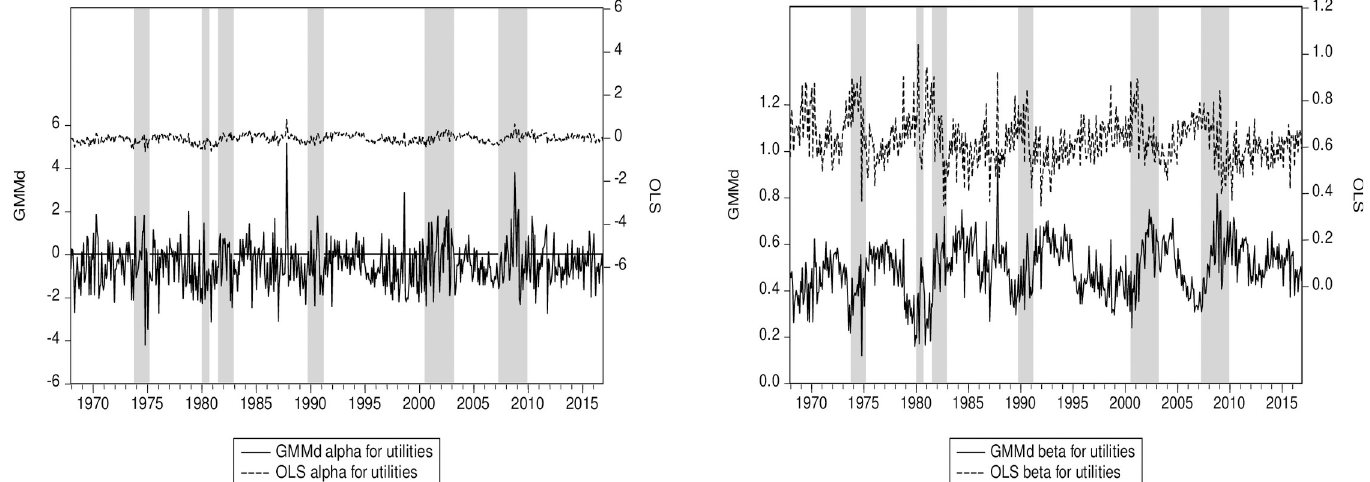
Fig 4. (a) Utilities alpha for RIV GMM and OLS. (b) Utilities beta for RIV GMM and OLS. Notes: This sector has the lowest OLS beta among the 12 sectors. RIV GMM (GMMd) is our robust instrumental variables approach. Shaded areas represent US recessions or crises. The OLS and GMM series are plotted on the same scale.